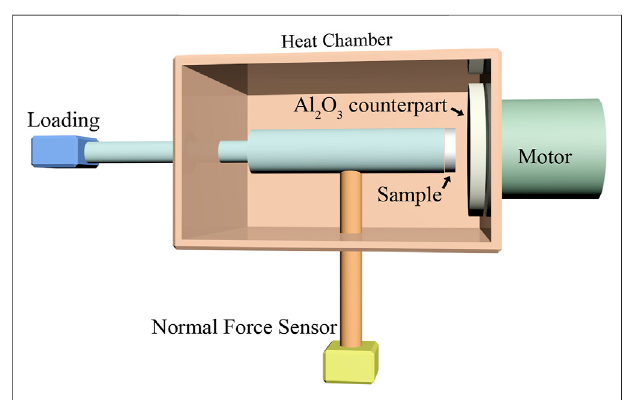
FIGURE 1 | Schematic diagram of high-temperature wear